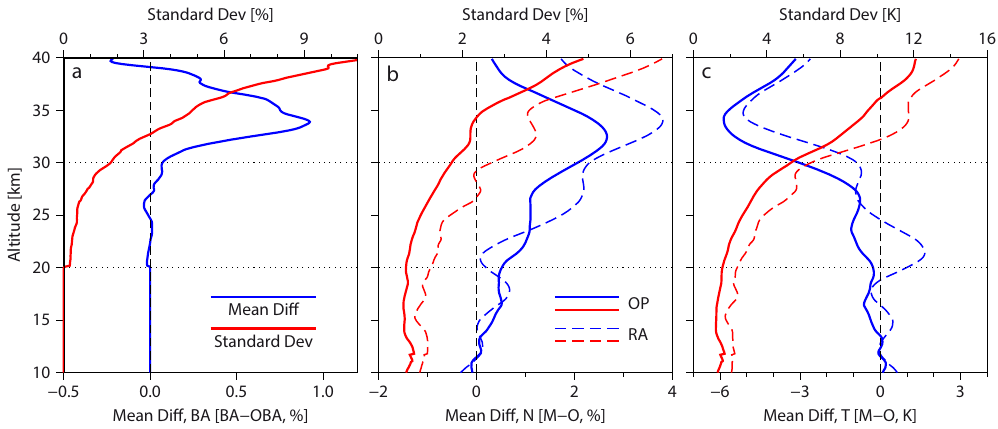
Figure 5. Statistical comparison of CDAAC retrievals over the Southern Hemisphere: (a) the difference between observed bending angle (denoted as BA) and optimized bending angle (OBA); (b) and (c) are the differences from ECMWF data (shown are M–O) in the refractivity and temperature, respectively. Blue curves denote differences in the mean and red curves indicate standard deviations. In (b) and (c) , solid curves are the comparisons with OP, whereas dashed curves are with